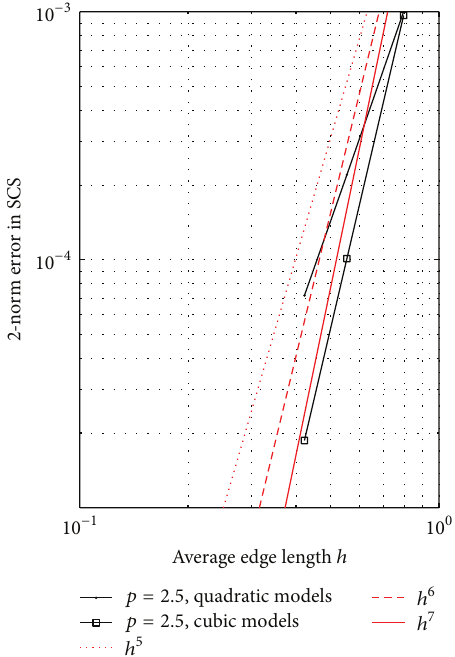
Figure 10: Error in the SCS versus the average edge lengths in the models, for the same torus used in Figures 7–9. EFIE results are reported for quadratic-curved and cubic-curved models used with 𝑝 = 2.5 functions. Asymptotic rates of 𝑂(ℎ 5 ) , 𝑂(ℎ 6 ) , and 𝑂(ℎ 7 ) are shown for